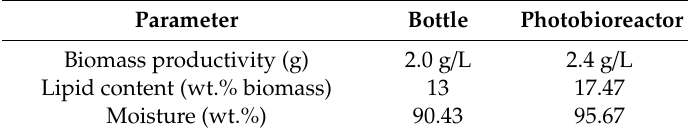
Table 4. Biomass productivity of Selenastrum capricornutum.